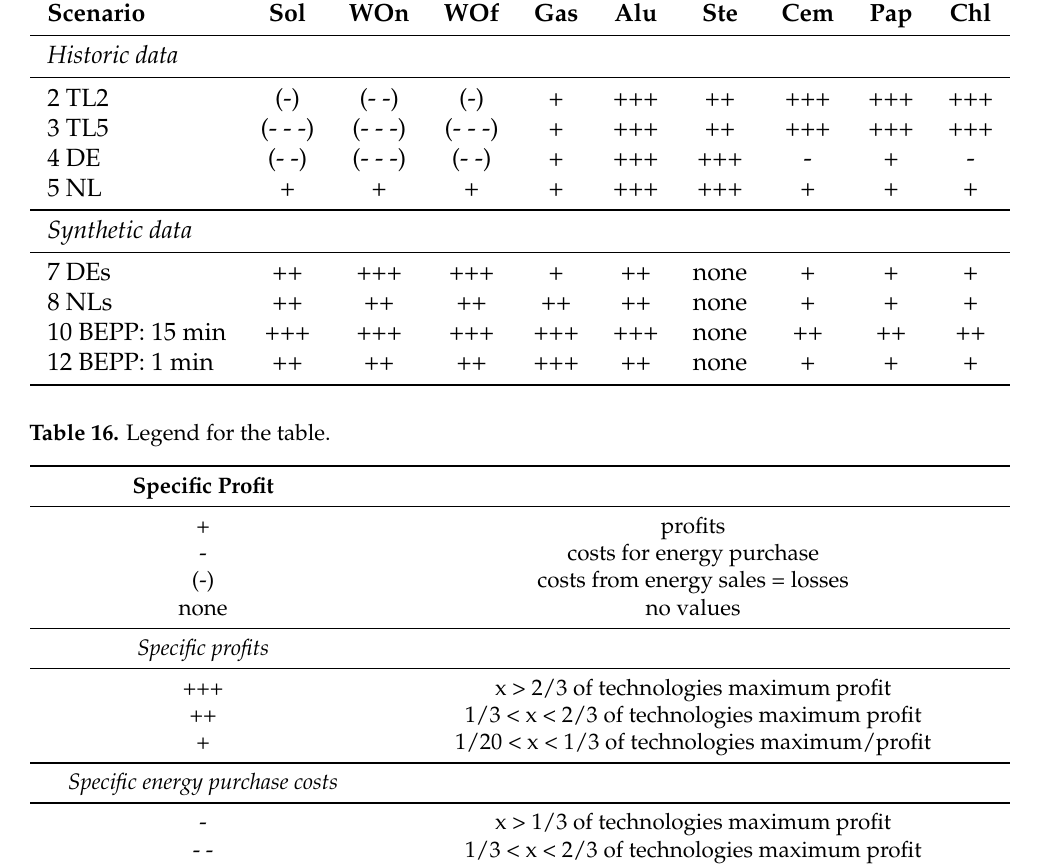
Table 15. Overview of the technologies’ specific profits in the investigated scenarios. Scenario